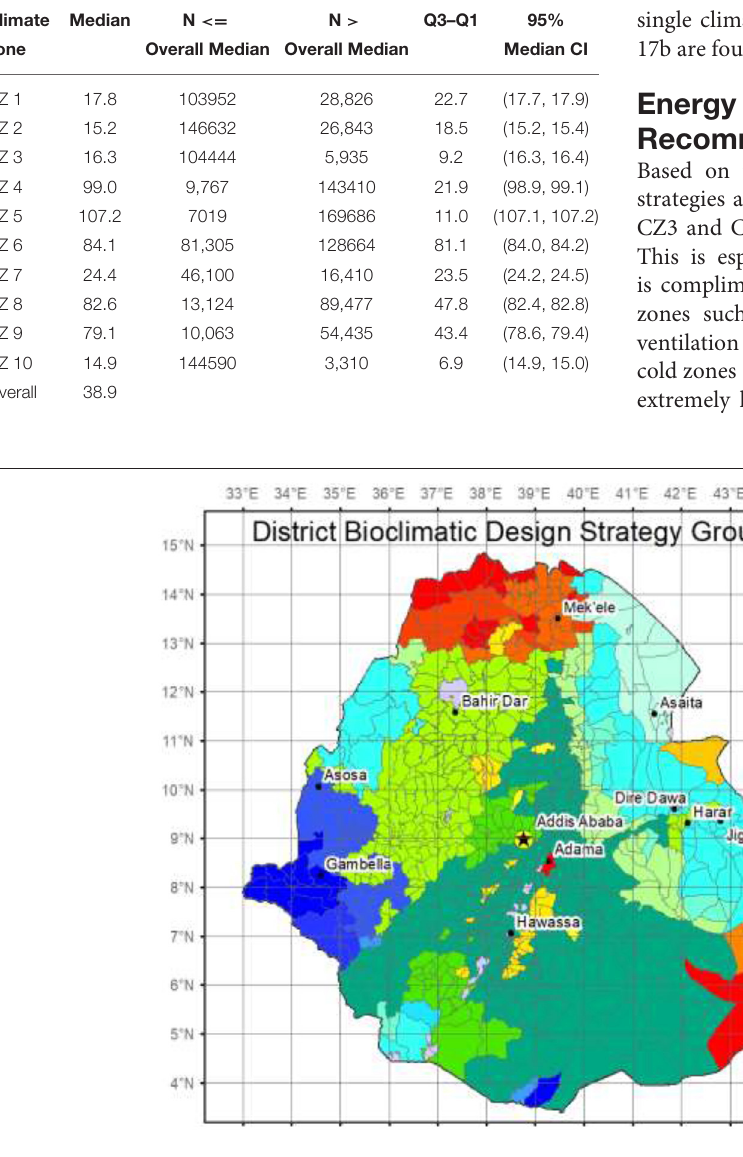
FIGURE 11 | District-level discretization of modified bioclimatic strategy groups (An expanded legend is presented in Appendix e).